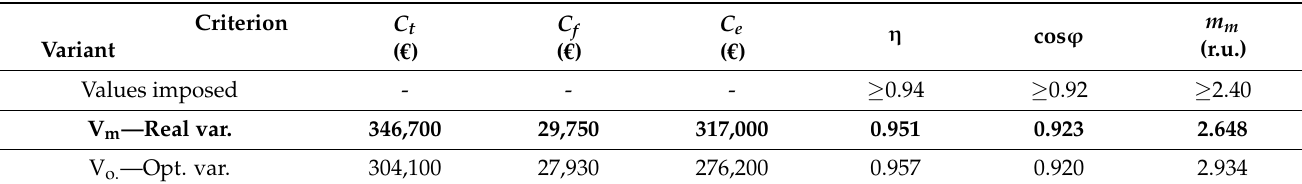
Table 5. Final optimum